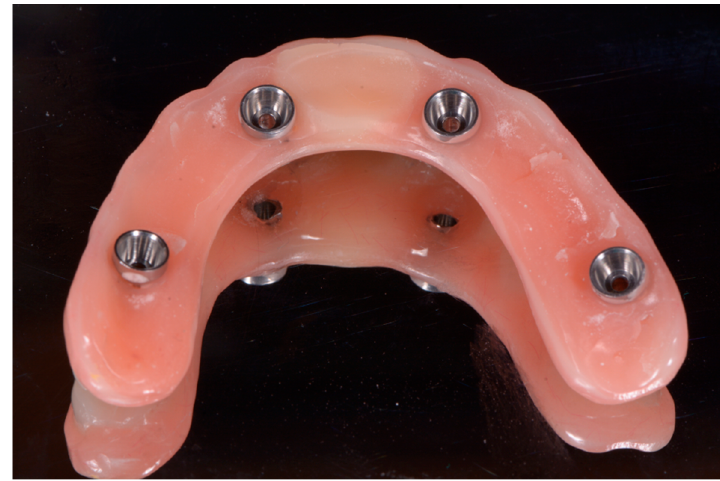
Figure 9. Flapless surgery.